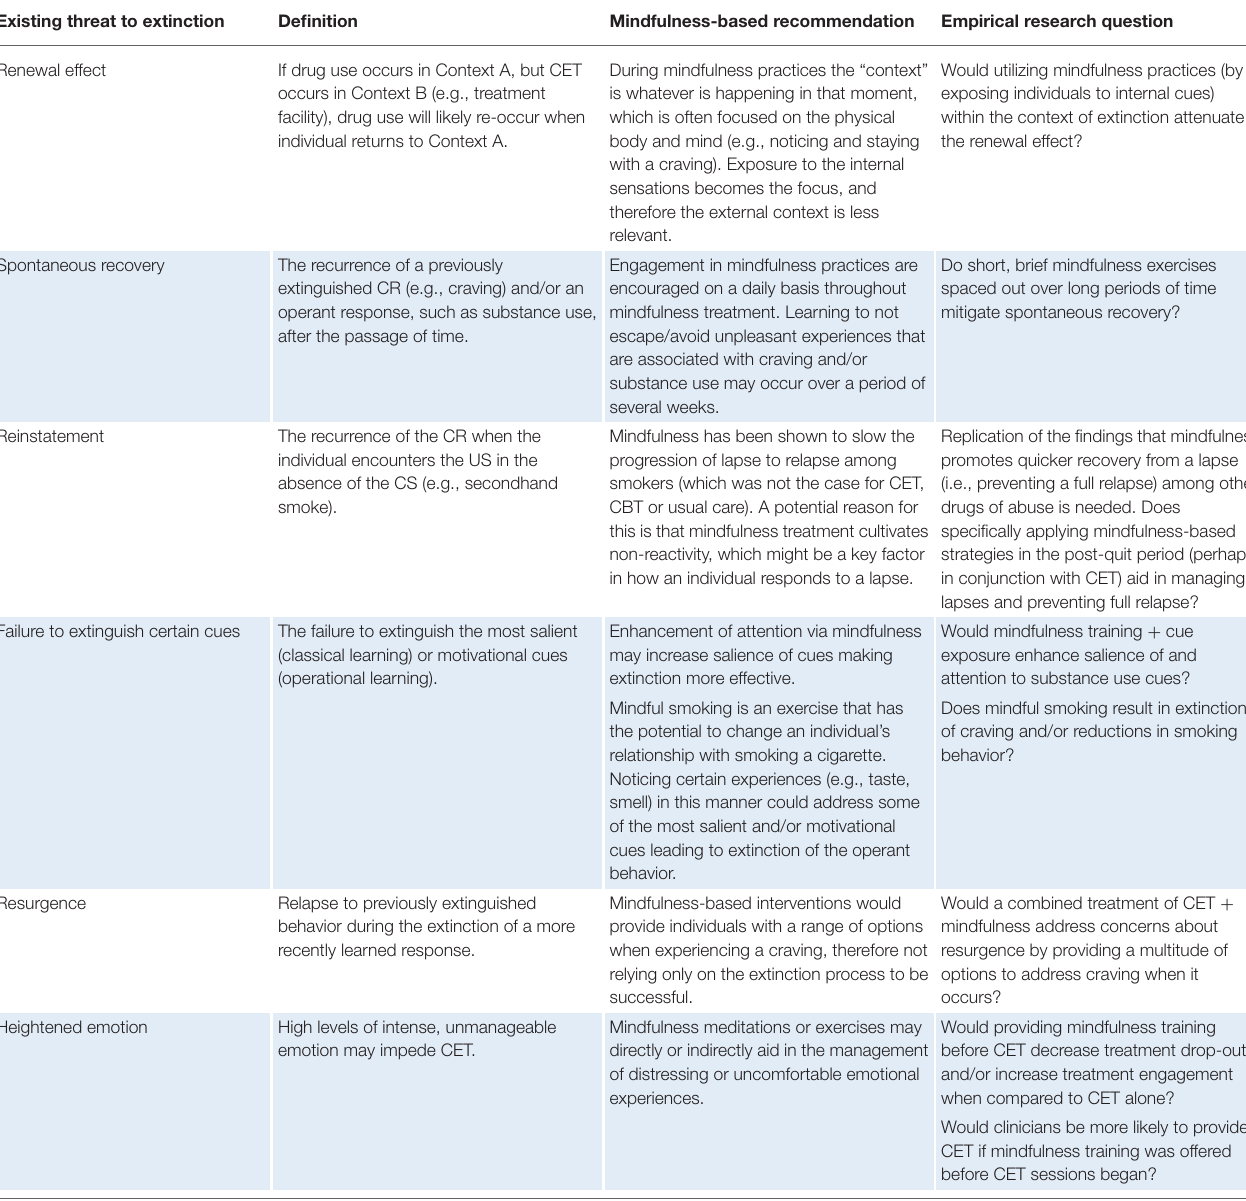
TABLE 1 | Mindfulness-based recommendations and empirical questions to address threats to